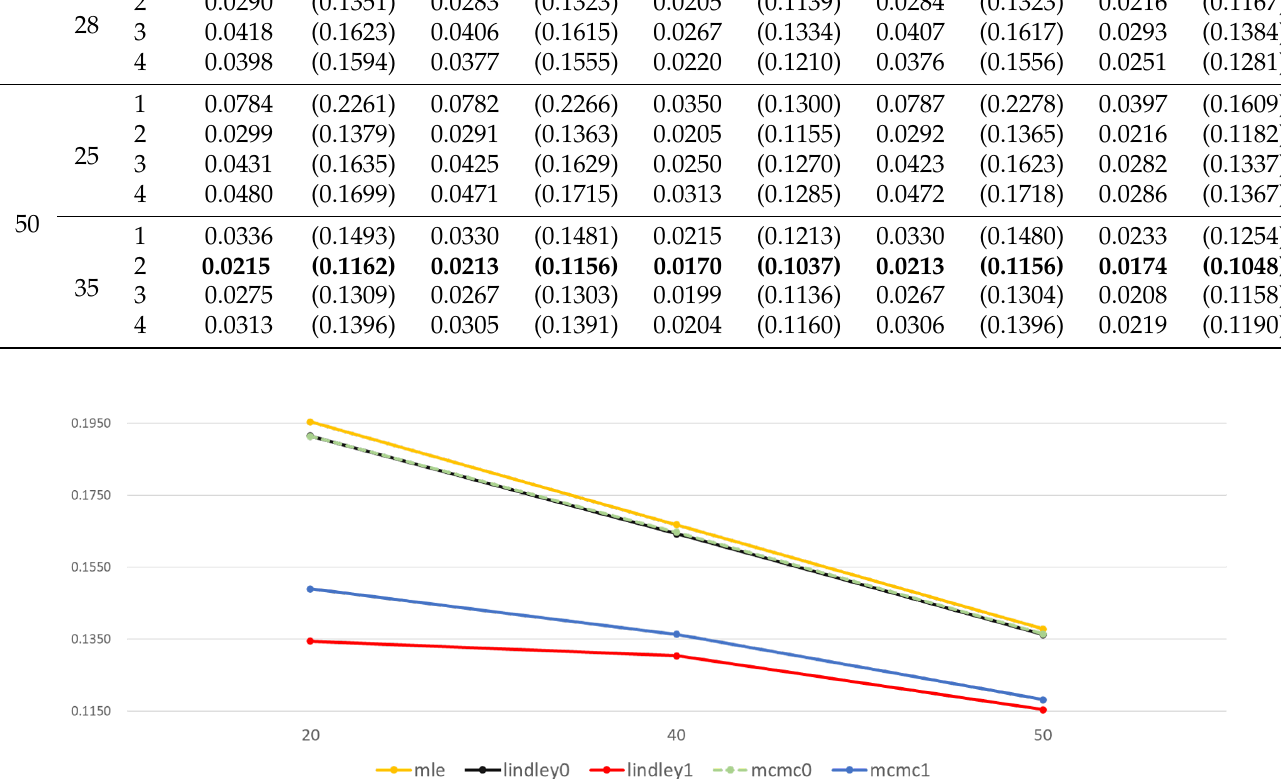
Figure 1. ABs of estimators of entropy under different methods and n